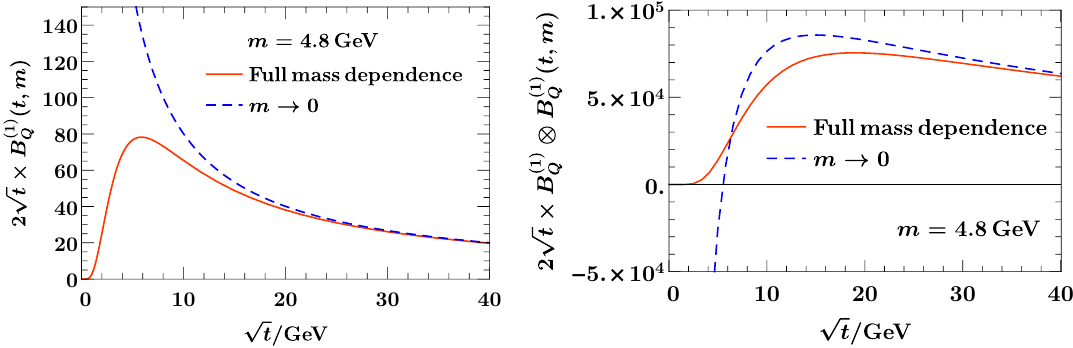
Figure 14 . Massive b -quark beam function (left panel) and the convolution between two of these (right panel) together with the m